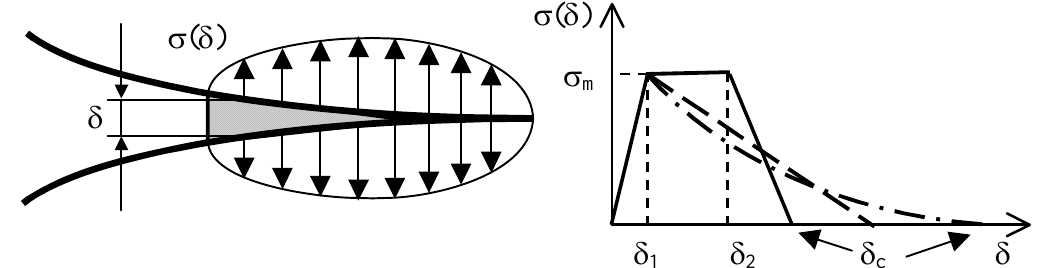
Figure 4: Outline of the cohesive zone traction-separation laws (Eqns. 4 - 6